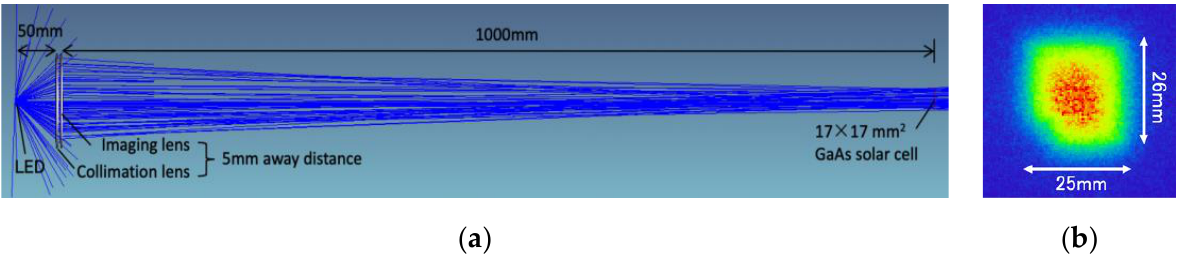
Figure 3. ( a ) Simulation model of a Fresnel lens collimation system; ( b ) Simulated irradiation spot.